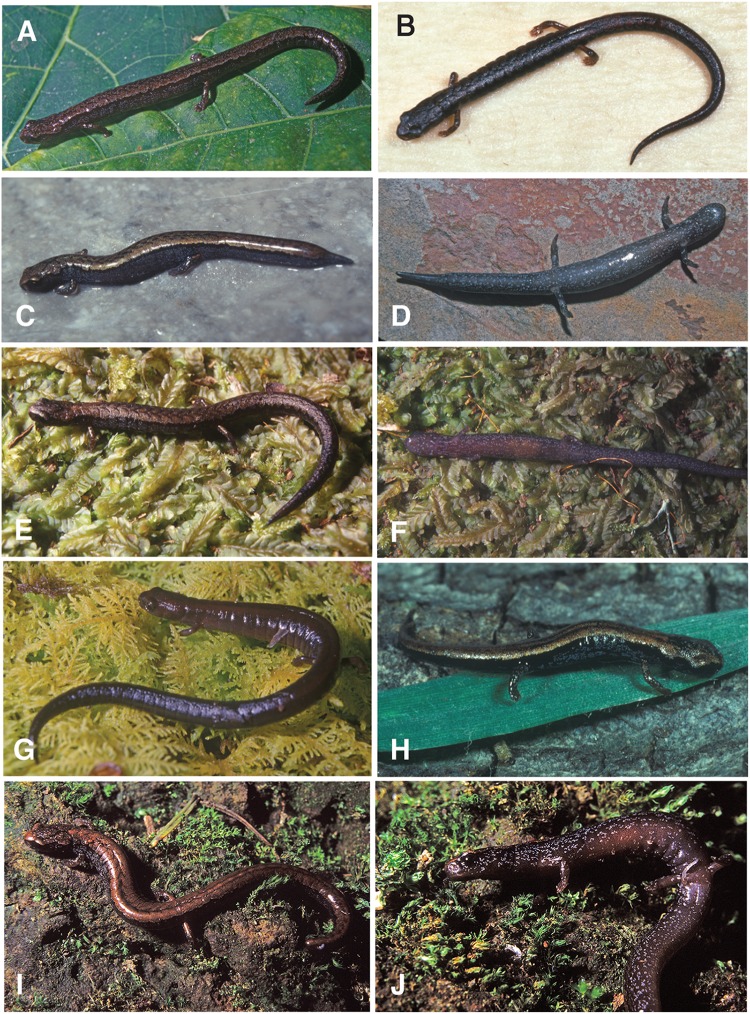
Salamanders in life.(A) Thorius pinicola from 1.7 km N of San Miguel Suchixtepec; MCZ A-136429. (B) Thorius longicaudus with complete tail from the type locality, 19 km S of Sola de Vega; museum number unavailable. (C, D) Thorius longicaudus with regenerating tail from the type locality, seen in dorsal and ventral views; IBH 13998. (E, F) Thorius minutissimus from the type locality, 1.1 km W of Santo Tomás Teipan, seen in dorsal and ventral views; IBH 23012. (G) Thorius narisovalis from Cerro San Felipe; IBH 14331. (H) Juvenile T. narisovalis from Cerro San Felipe lying on a blade of grass. (I, J) Thorius tlaxiacus from the type locality, 27.3 km SSE (by road) Tlaxiaco, seen in dorsal and ventrolateral views; MCZ 148746. (A, C–G, I and J) Photos by M. García-París and (B and H) J. Hanken.